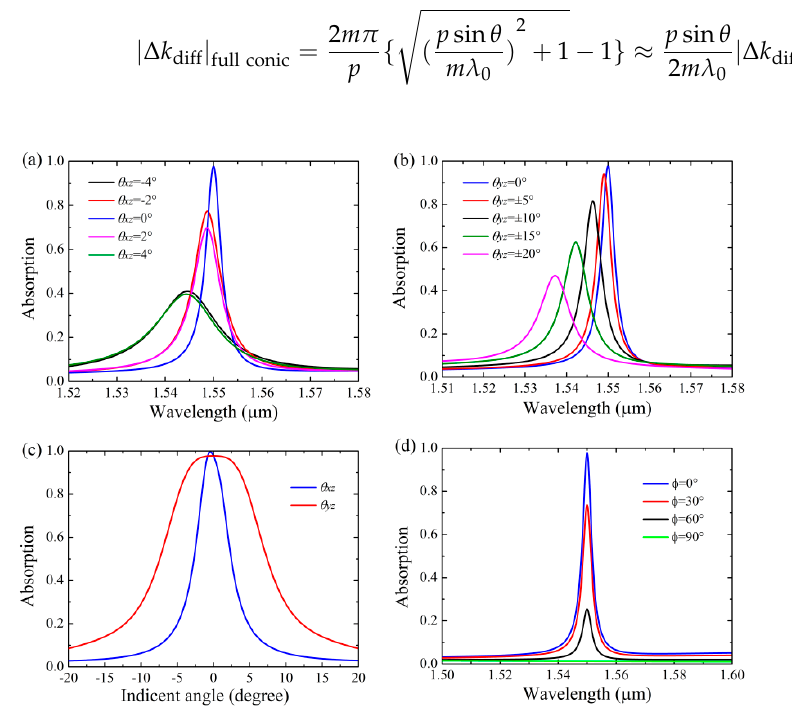
Figure 7. Absorption spectra of the Si-based PCS with graphene under the variations of incident angle θ and polarization angle φ with s = 74 nm, other parameters are the same as Figure 2. ( a ) Absorption spectra as a function of the incident angle in the xz plane. ( b ) Absorption spectra as a function of the incident angle in the yz plane. ( c ) Angular response for the central wavelength of 1.55 µ m in both the xz and yz planes. ( d ) Absorption spectra as a function of the polarization angle.